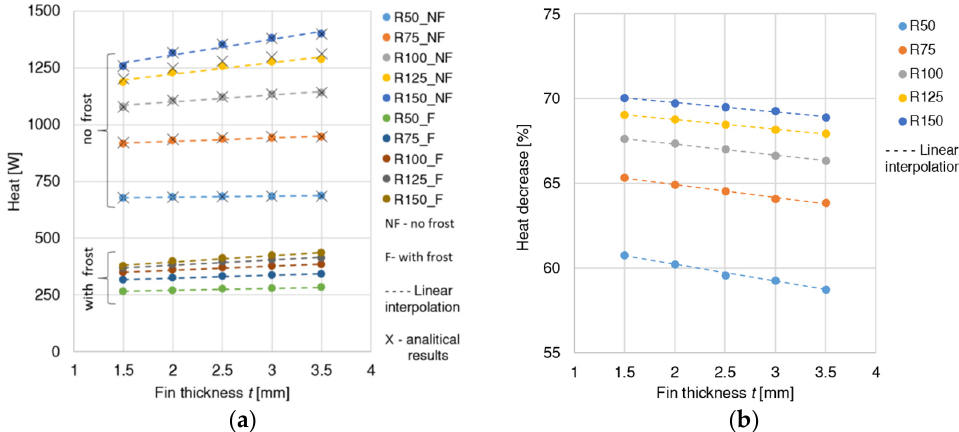
Figure 14. ( a ) Heat transferred through the 1 m length of the finned tube with 4 fins, ( b ) Heat decrease due to frosting.